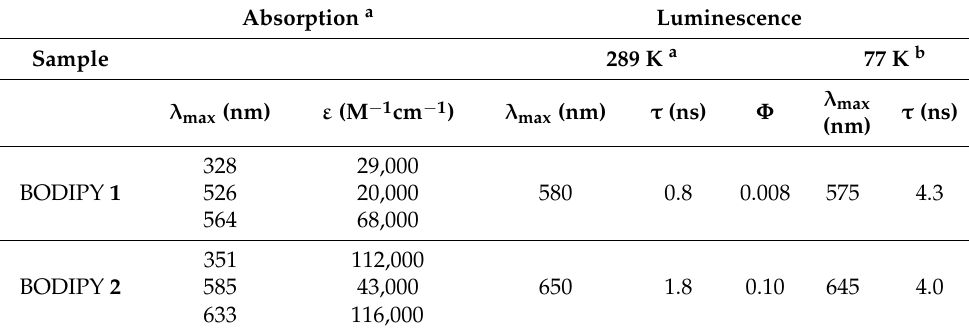
Table 1. Photophysical properties of BODIPYs 1 and 2 .